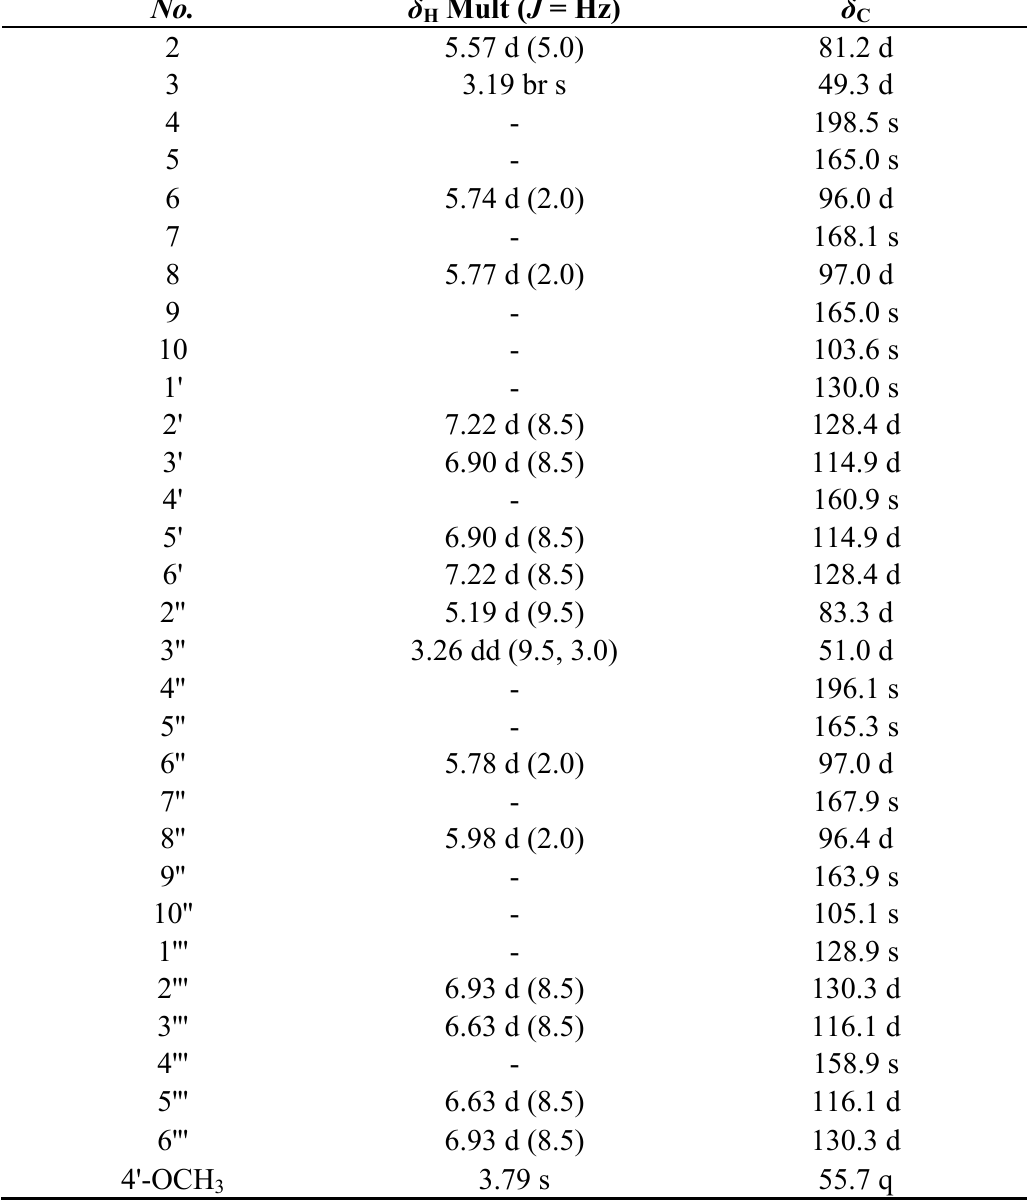
OD (500 MHz for 1 H, 125 MHz for 13 3